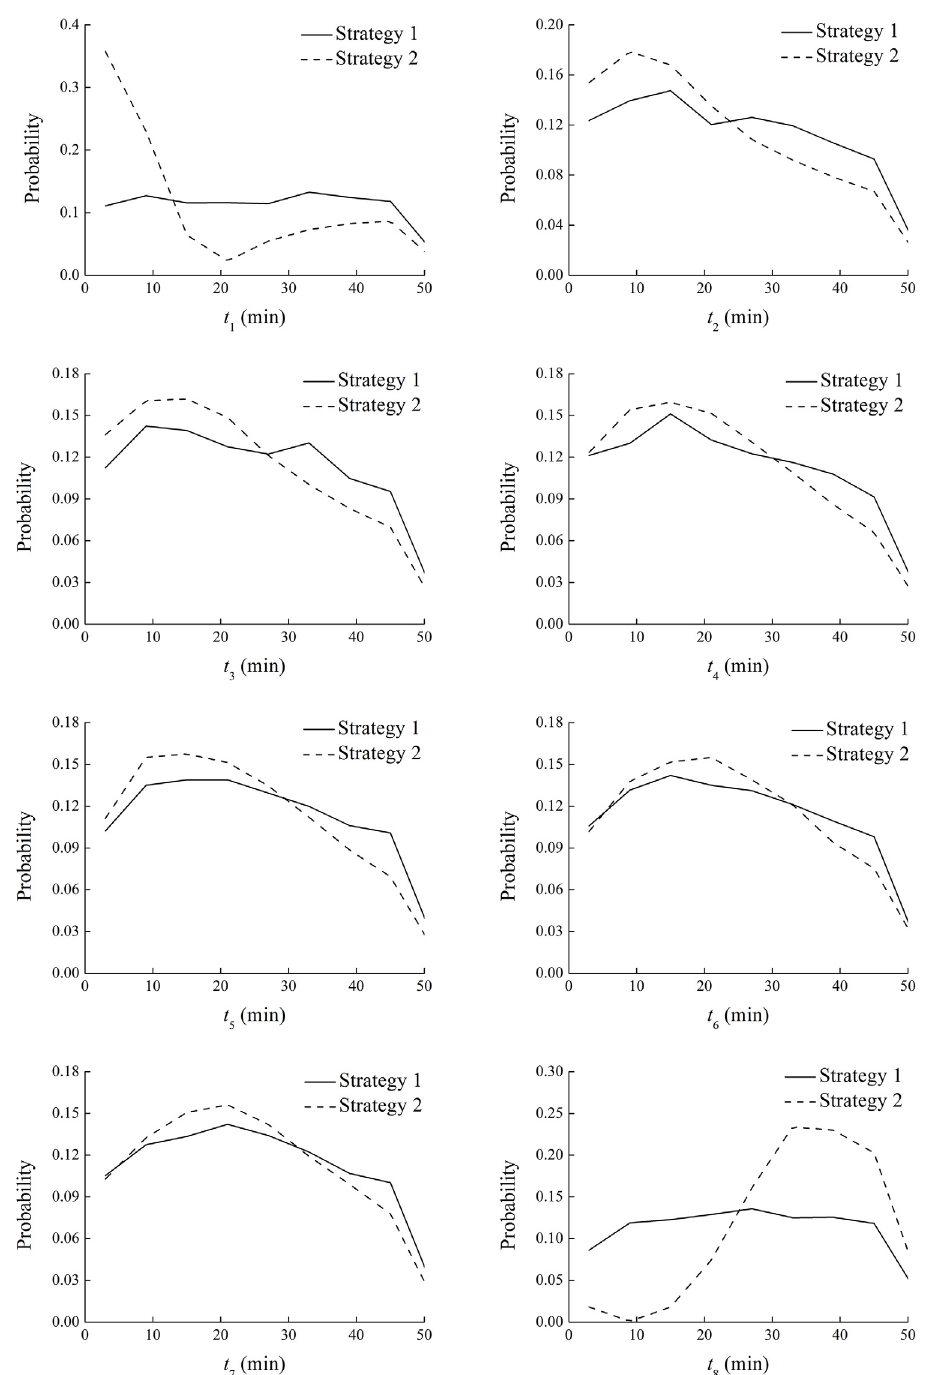
Fig 4. Posterior probability distributions of the behavior-giving t 1 ~ t 8 with Strategy 1 and